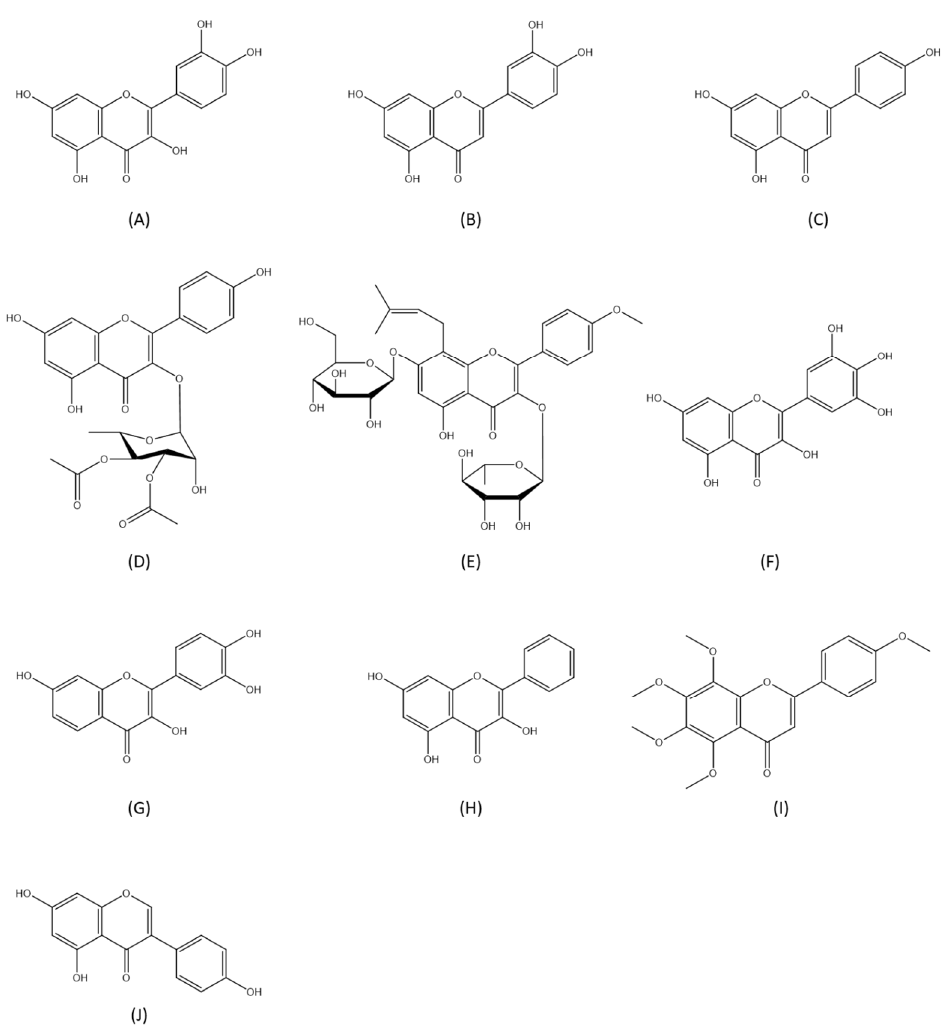
Figure 2. Chemical structures of flavonoids with potential preventive effects of aucte kidney injury. ( A ) Quercetin; ( B ) Luteolin; ( C ) Apigenin; ( D ) Kaempferol; ( E ) Icariin; ( F ) Myricetin; ( G ) Fisetin; ( H ) Galangin; ( I ) Tangeretin; ( J ) Genistein.